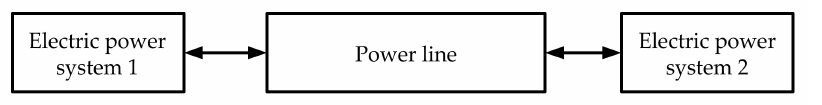
Figure 1. Structural diagram of an electric power network supply system.